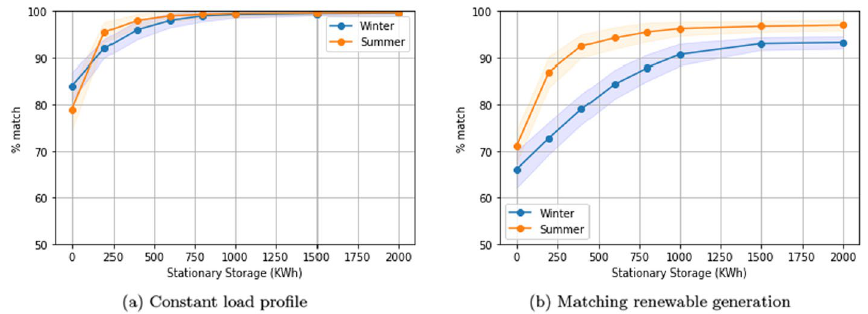
Fig. 9 Comparison of the performance of our solution in winter and summer months. One-way charging in a residential setting